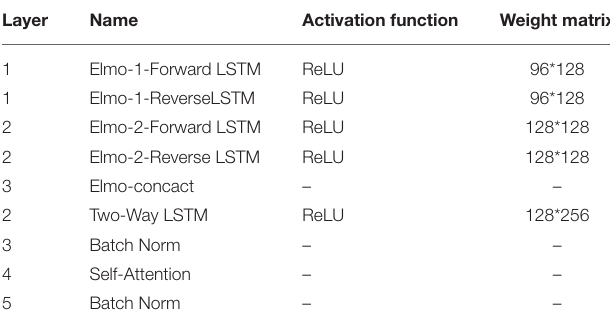
TABLE 3 | LSTM network structure on the right.